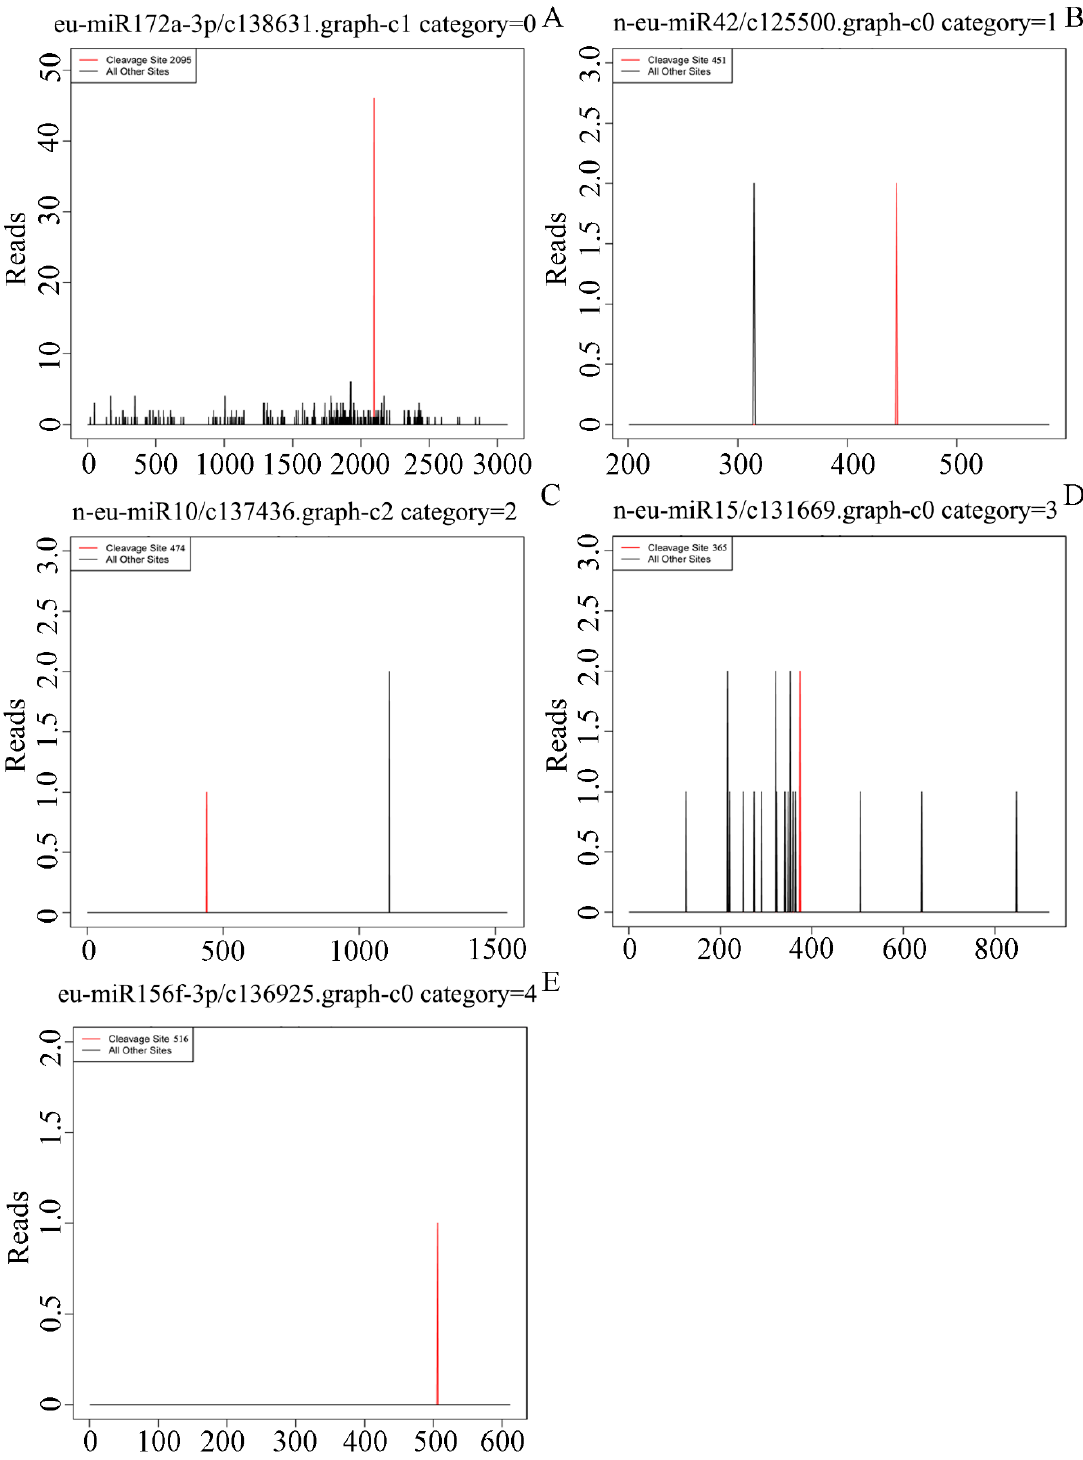
Figure 4. Target plots (T-plots) for miRNA targets in the five different categories validated by degradome sequencing. The x-axis indicates the site position of target cDNA, and the y-axis indicates the normal abundance of raw tags. The red line indicates the identified cleavage site. ( A ) Example of the category 0; ( B ) example of the category 1; ( C ) example of the category 2; ( D ) example of the category 3; ( E ) example of the category 4.